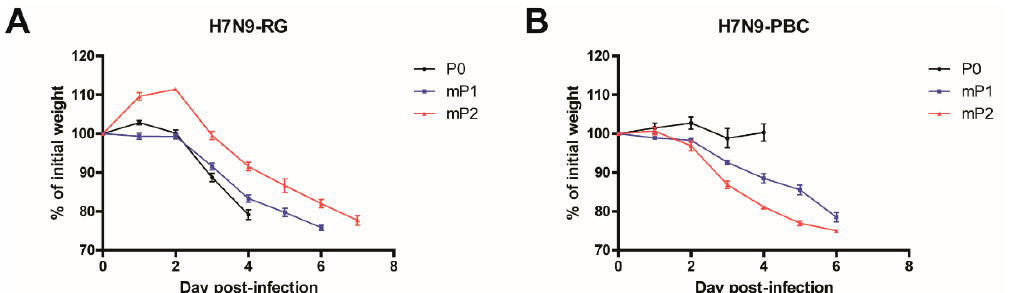
Figure 2. Pathogenesis of influenza A (H7N9) viruses containing a polybasic HA cleavage site upon serial passaging in mice. Mice ( n = 3) were infected with 7 x 10 5 PFU of either ( A ) A / Anhui / 1 / 2013 (H7N9-RG, P0) or ( B ) A / Anhui / 1 / 2013 (H7N9) containing a polybasic HA cleavage site (H7N9-PBC, P0). Mice were sacrificed on day 4 post-infection and lung homogenates from each mouse was collected for passaging. For the first passage of H7N9-RG and H7N9-PBC viruses in mice (mP1), groups of mice ( n = 6) were infected with 50 µ L of lung homogenates collected from P0 infected mice, respectively. For the second passage (mP2), three mice from each mP1-infected group were sacrificed on day 6 post-infection, and lung homogenates were collected and used to infect mice ( n = 3). Mean weight loss (%) ± standard error of mean of infected mice are shown.